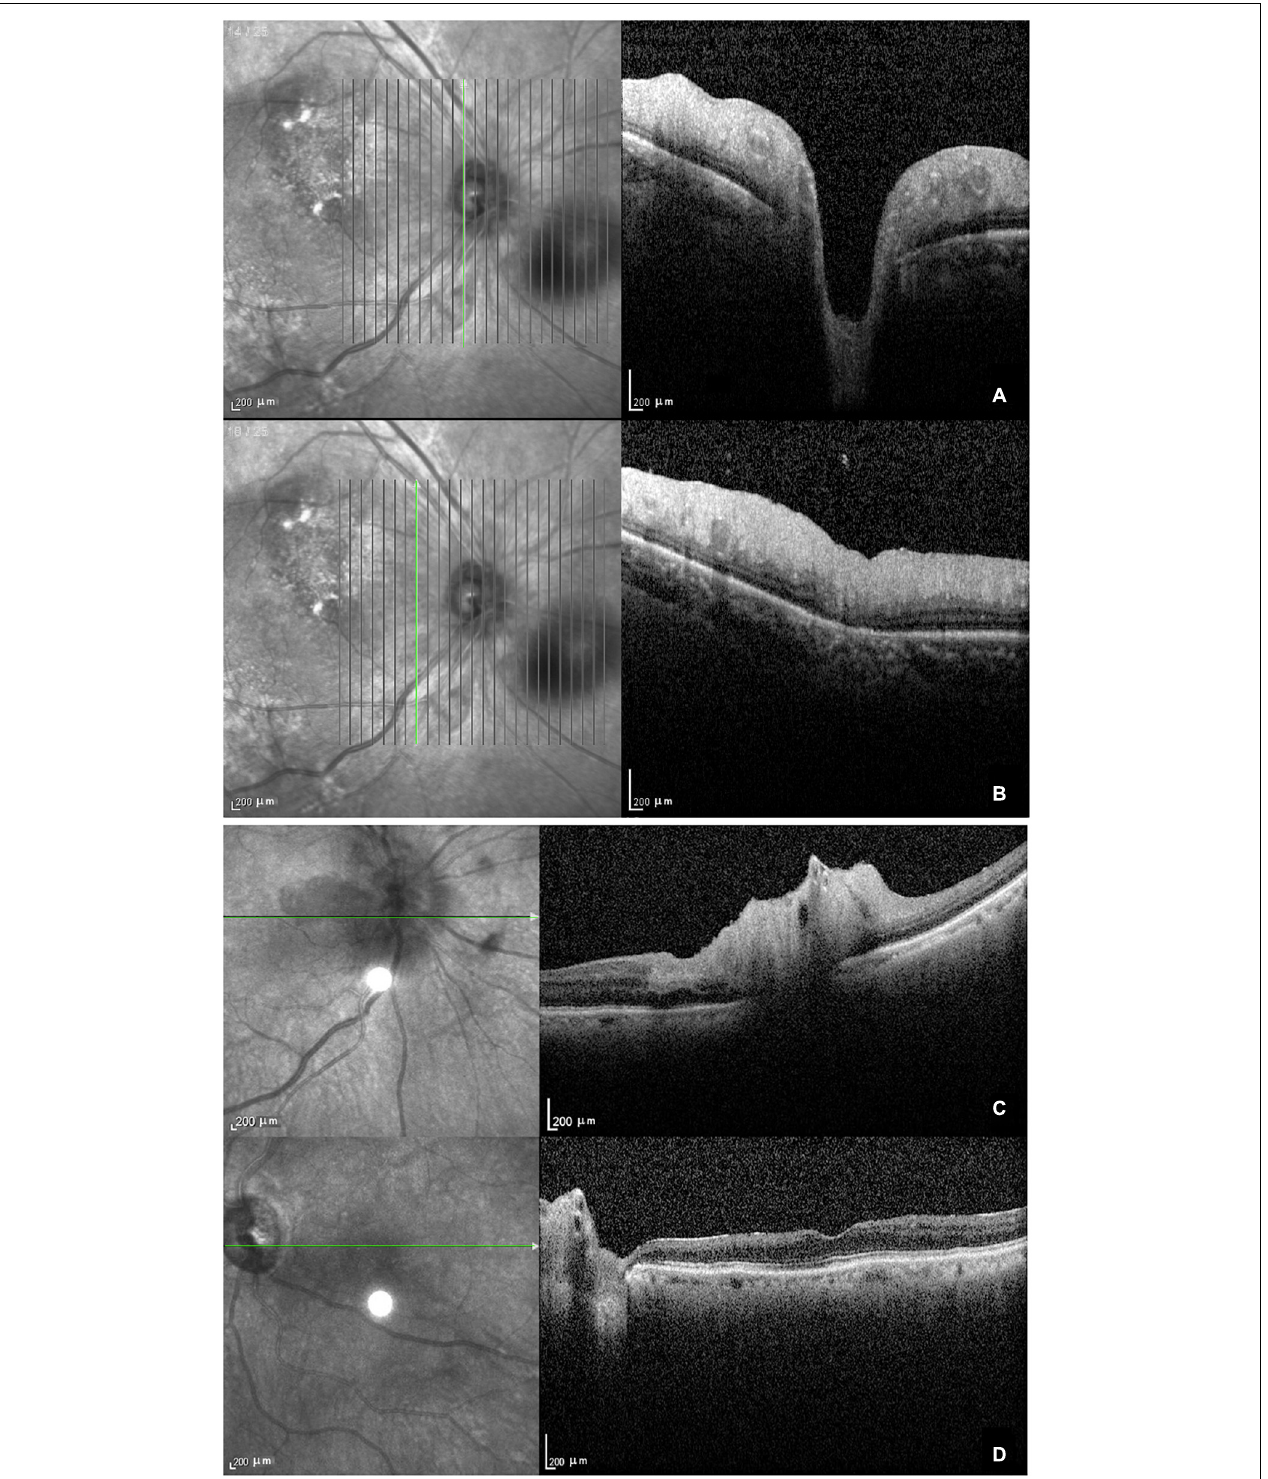
FIGURE 2 | Optical coherence tomography in patients with giant cell arteritis. (A) Optic disc edema with a loss of layer structure in the inner retina; (B) edematous thickening of the peripapillary retinal nerve fiber layer and ganglion cell layer; (C) arteritic anterior ischemic optic neuropathy combined with ciliary vascular obstruction showing edema of the optic disc, thickening, and a loss of layer structure in the inner retina; (D) atrophy and thinning of the retinal nerve fiber layer and ganglion cell layer with epiretinal membrane at the late stage.